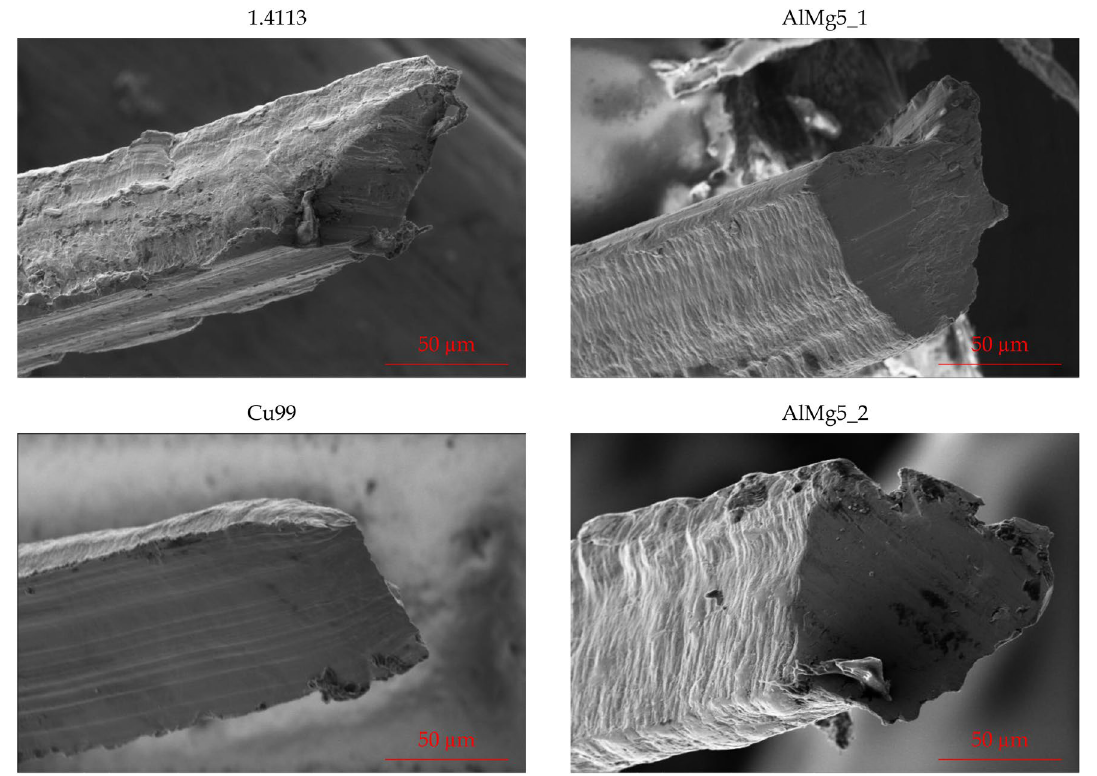
Fig. 9 SEM analysis: end faces of metal staple fibres 1.4113, AlMg5( − 1 & − 2) and Cu99